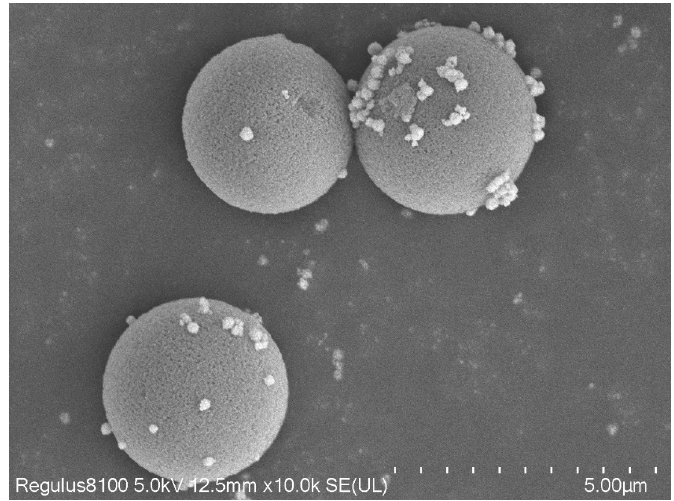
Figure 13. SEM image after organic resin coating.